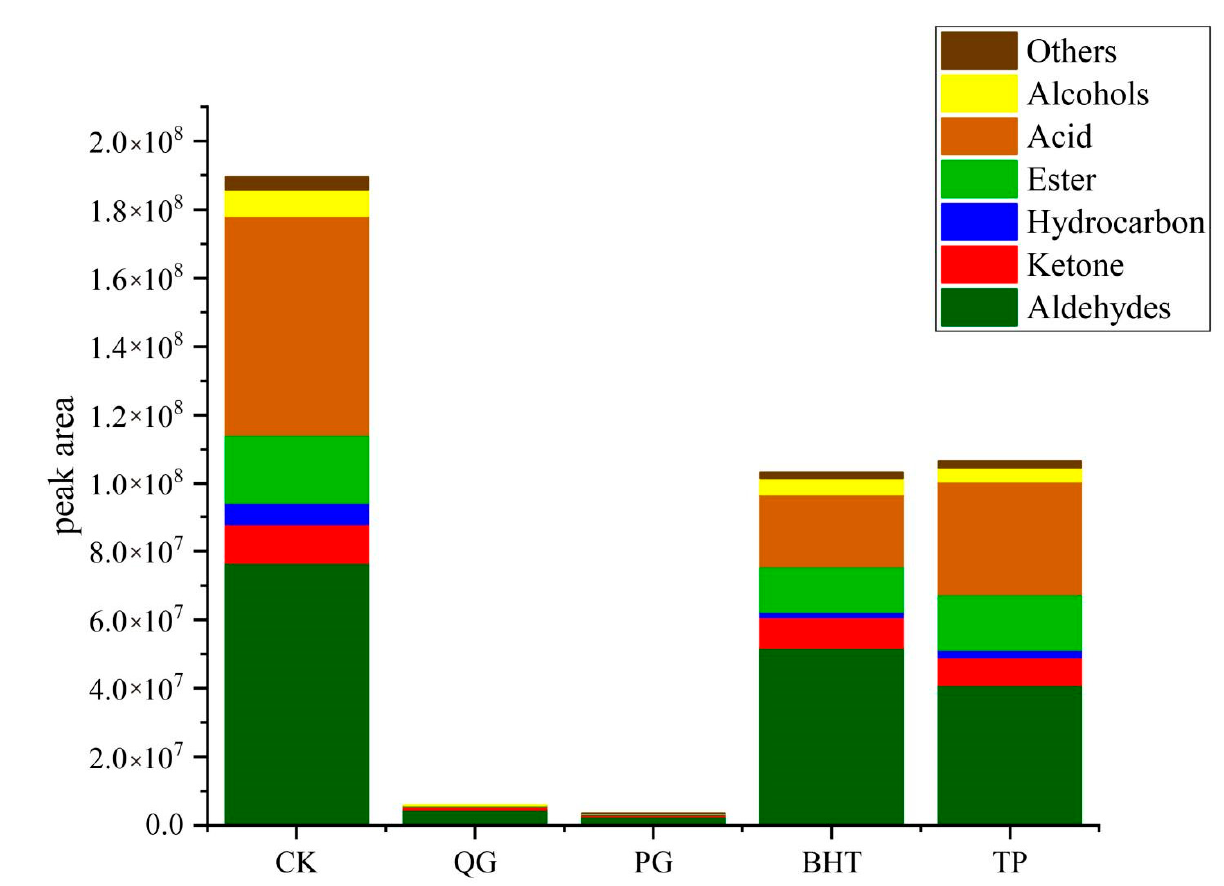
Figure 6. Peak area of various volatile fractions from soybean oil treated with different antioxidants according to HS-SPME-GC-MS.